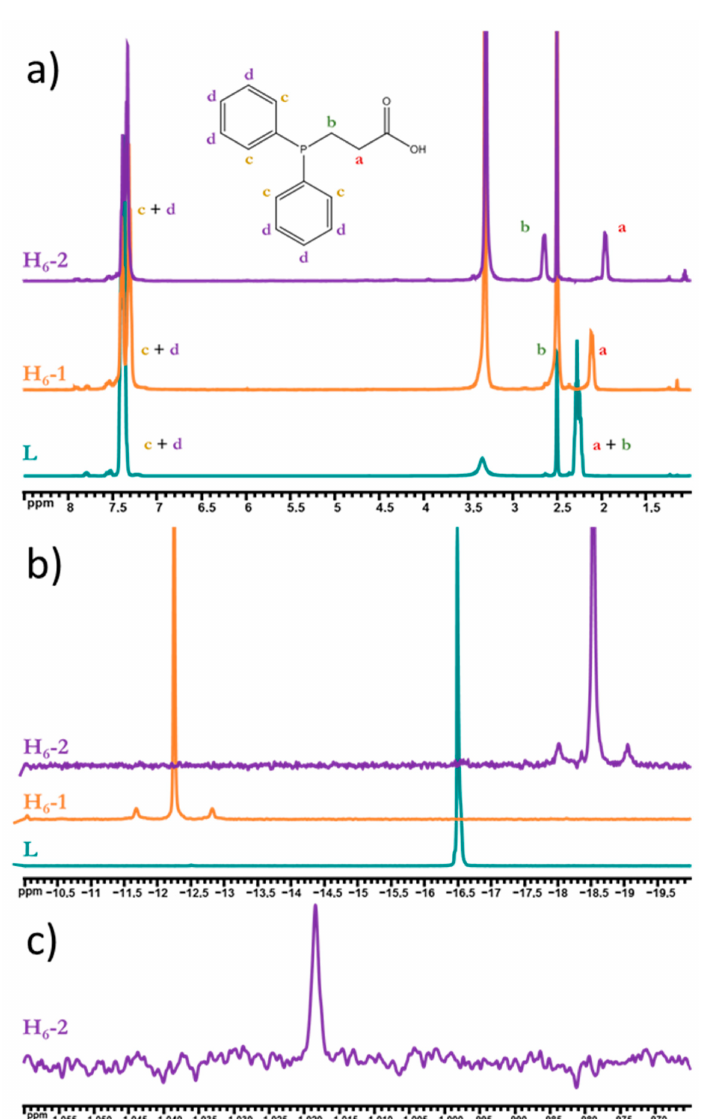
Figure 2. 1 H ( a ), 31 P ( b ), 77 Se ( c ), and NMR spectra of H 6 - 1 and H 6 - 2 in DMSO-d 6 in comparison to PPh 2 C 2 H 4